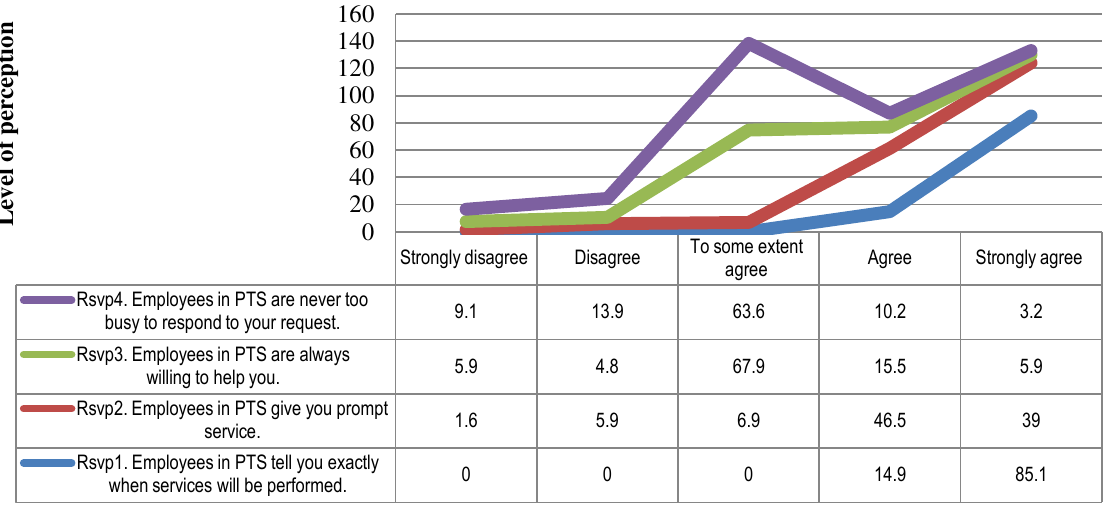
Fig. 9. Level of perception on responsiveness about PTS percentage of research respondents